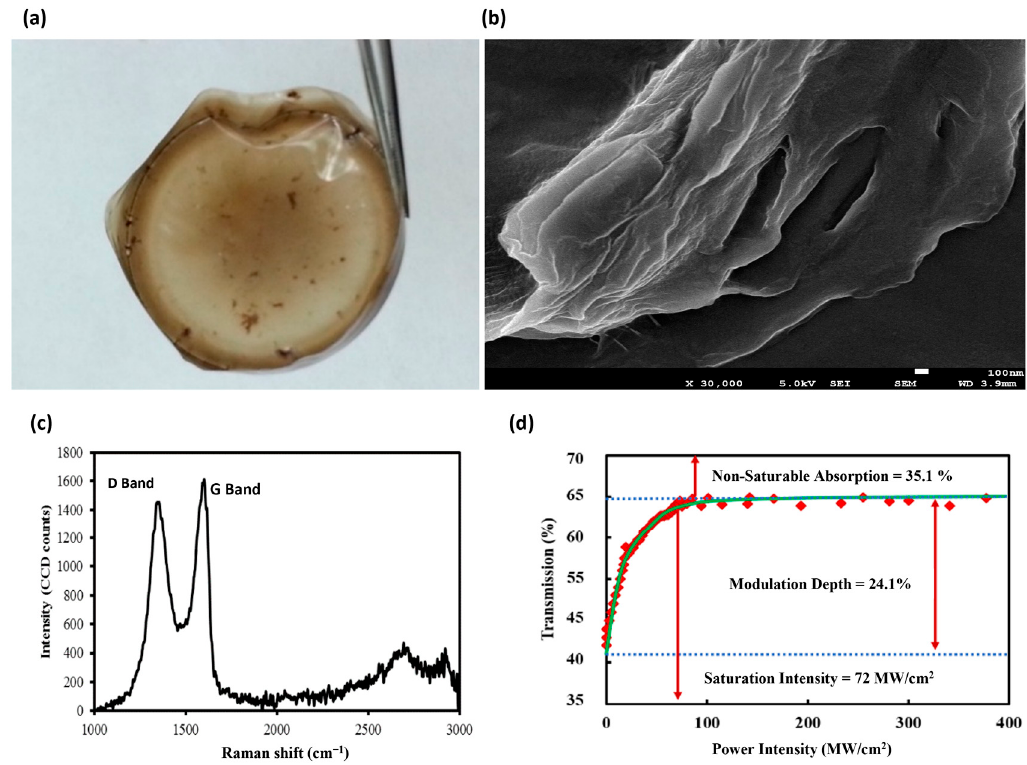
Figure 1. Fabrication and characterization of GO-PEO film: ( a ) GO-PEO film after letting it dry at room temperature; ( b ) FESEM image of GO-PEO film; ( c ) Raman spectrum from the GO-PEO film; ( d ) Modulation Depth of the GO-PEO film.